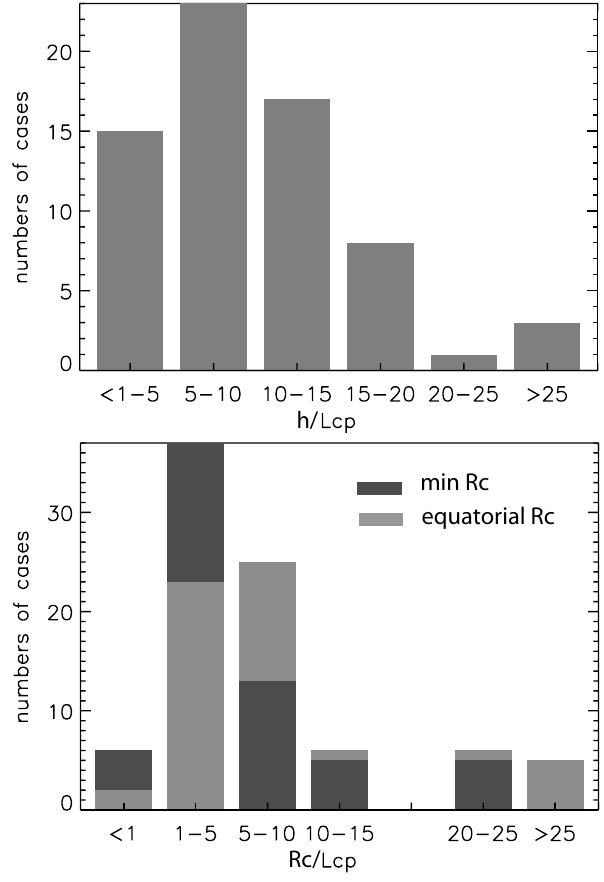
Fig. 10. Occurrence rates of current sheet half-thicknesses h and magnetic field curvature radii R c (minimum and median in the NS). h and R c are normalized by the characteristic plasma scale L cp (see details in text).